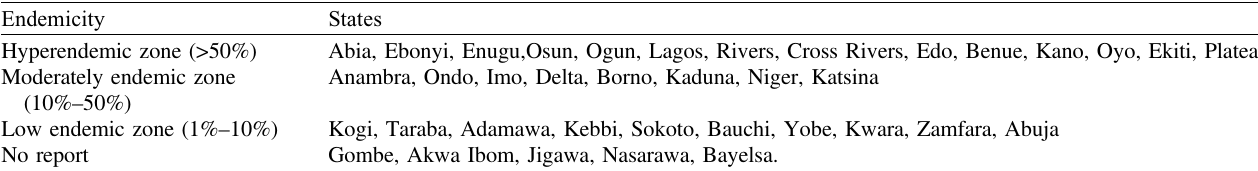
Table 2. Ranking of endemicity by state. Endemicity